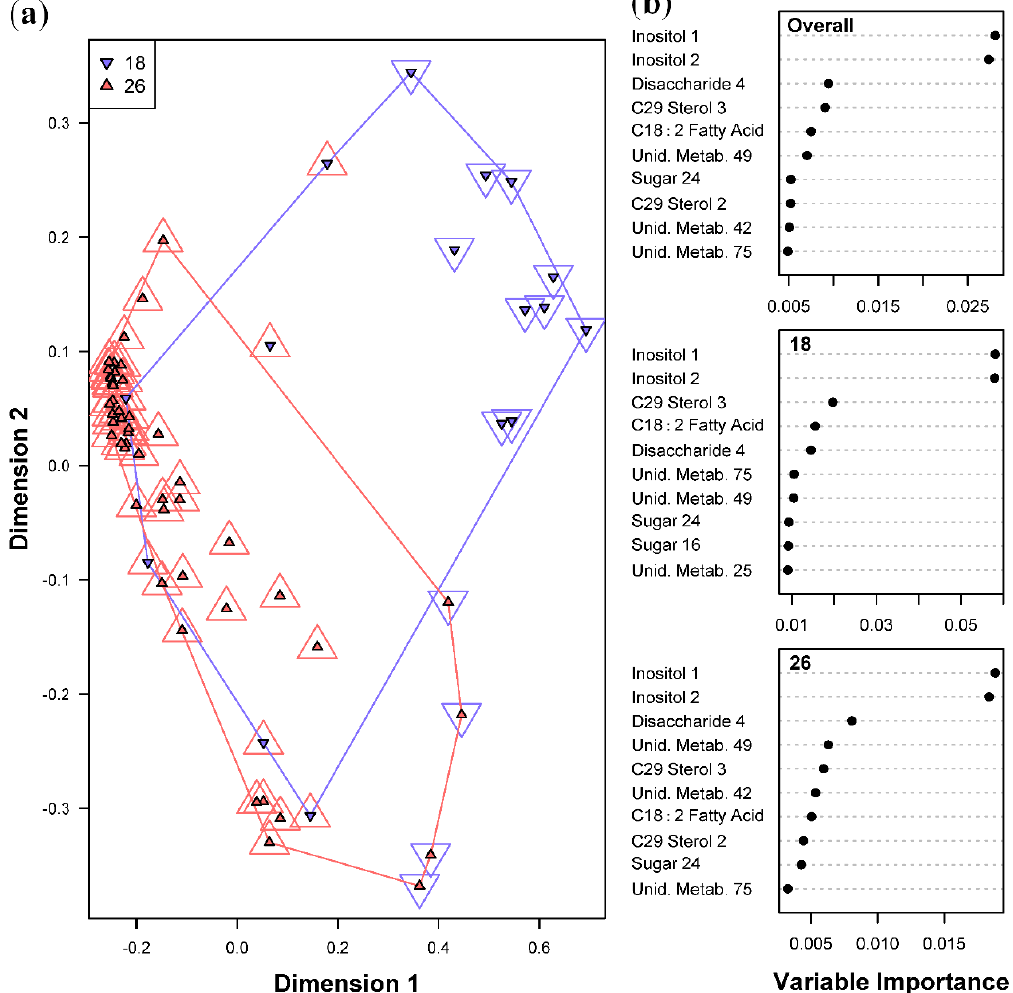
Figure 3. Random Forests classification of temperature (18 and 26 °C). ( a ) Plot of proximities of all 64 samples from 5000 Random Forests trees as projected on the first two Principal Coordinate dimensions. Color and shape of the central filled points indicate the temperature the sample was cultured in (18 and 26 °C), while the surrounding color and shape indicate the temperature predicted by Random Forests. Colored lines are convex hulls linking the outermost points of each temperature; ( b ) Distribution of importance scores for the 10 most important predictor metabolites (based on mean decrease in prediction accuracy). Plot labeled “Overall” depicts metabolites found to be important for overall prediction accuracy. Other plots show metabolites important for classifying each